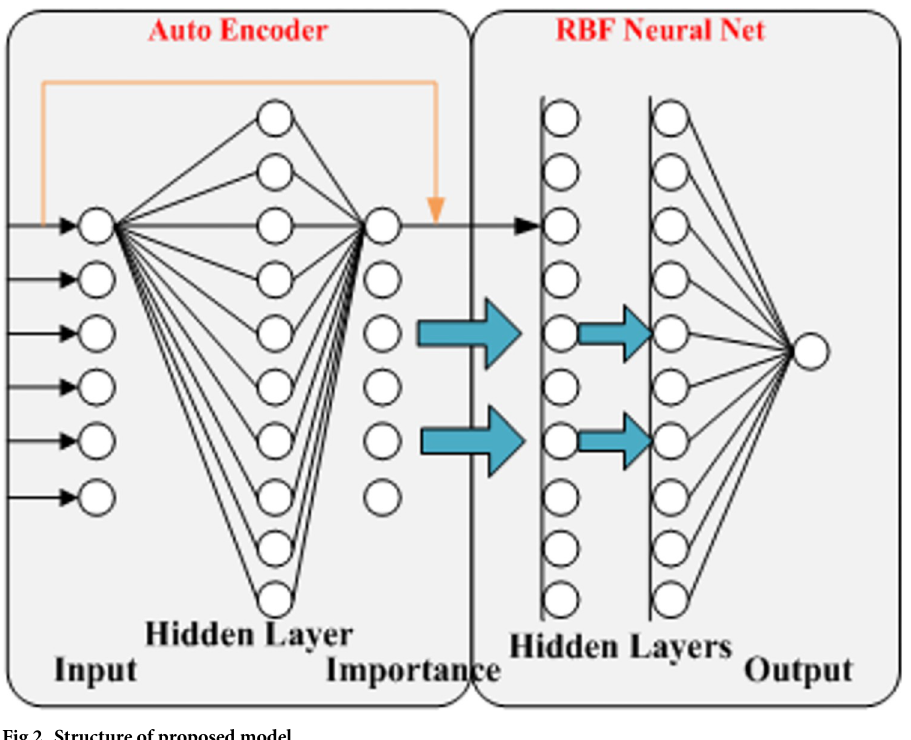
Fig 2. Structure of proposed